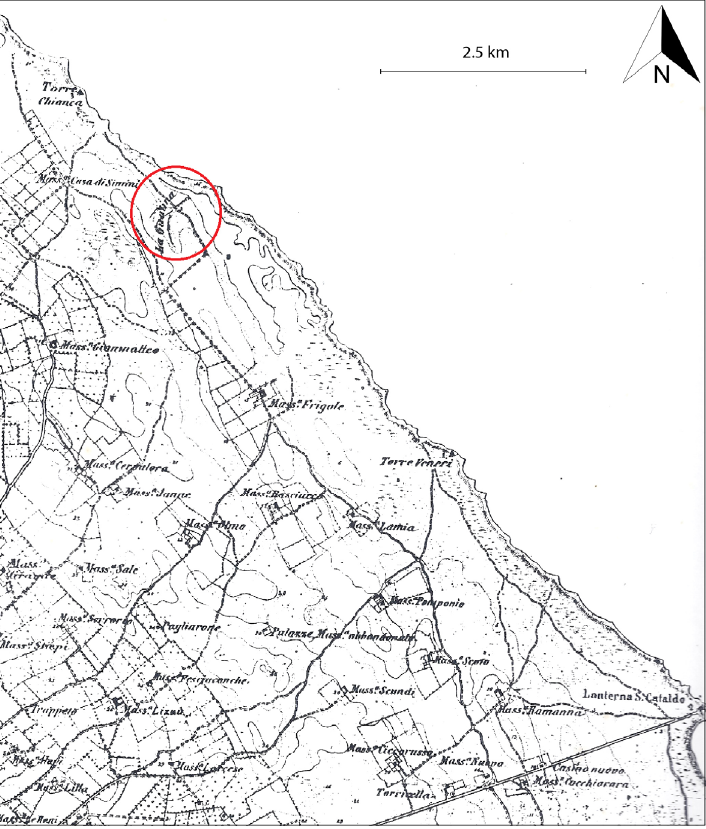
Figure 5. 1879 topographic map of the studied area: At that time, the Giammatteo Channel flowed into the Acquatina di Frigole lagoon (red circle).